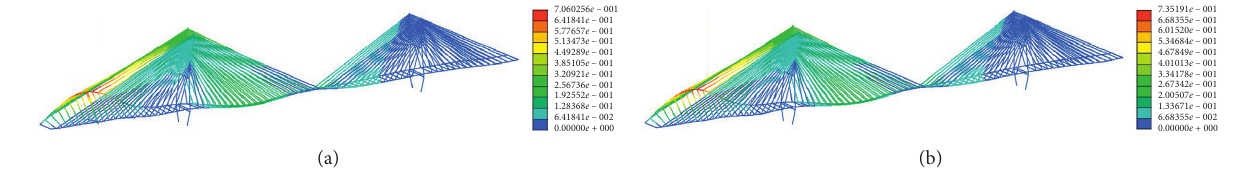
Figure 14: Displacement responses for the emergency rescue cases (unit: m): (a) repair scheme 1 and (b) repair scheme 2.